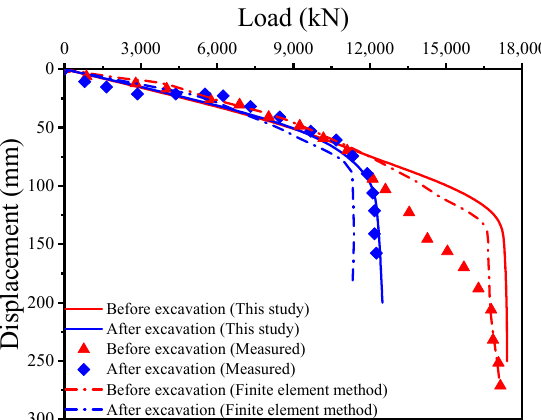
Figure 11. Comparison between the results from finite element method, centrifuge test and the proposed approach before and after excavation.